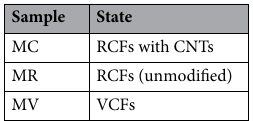
Table 2. Summary of the DCB test